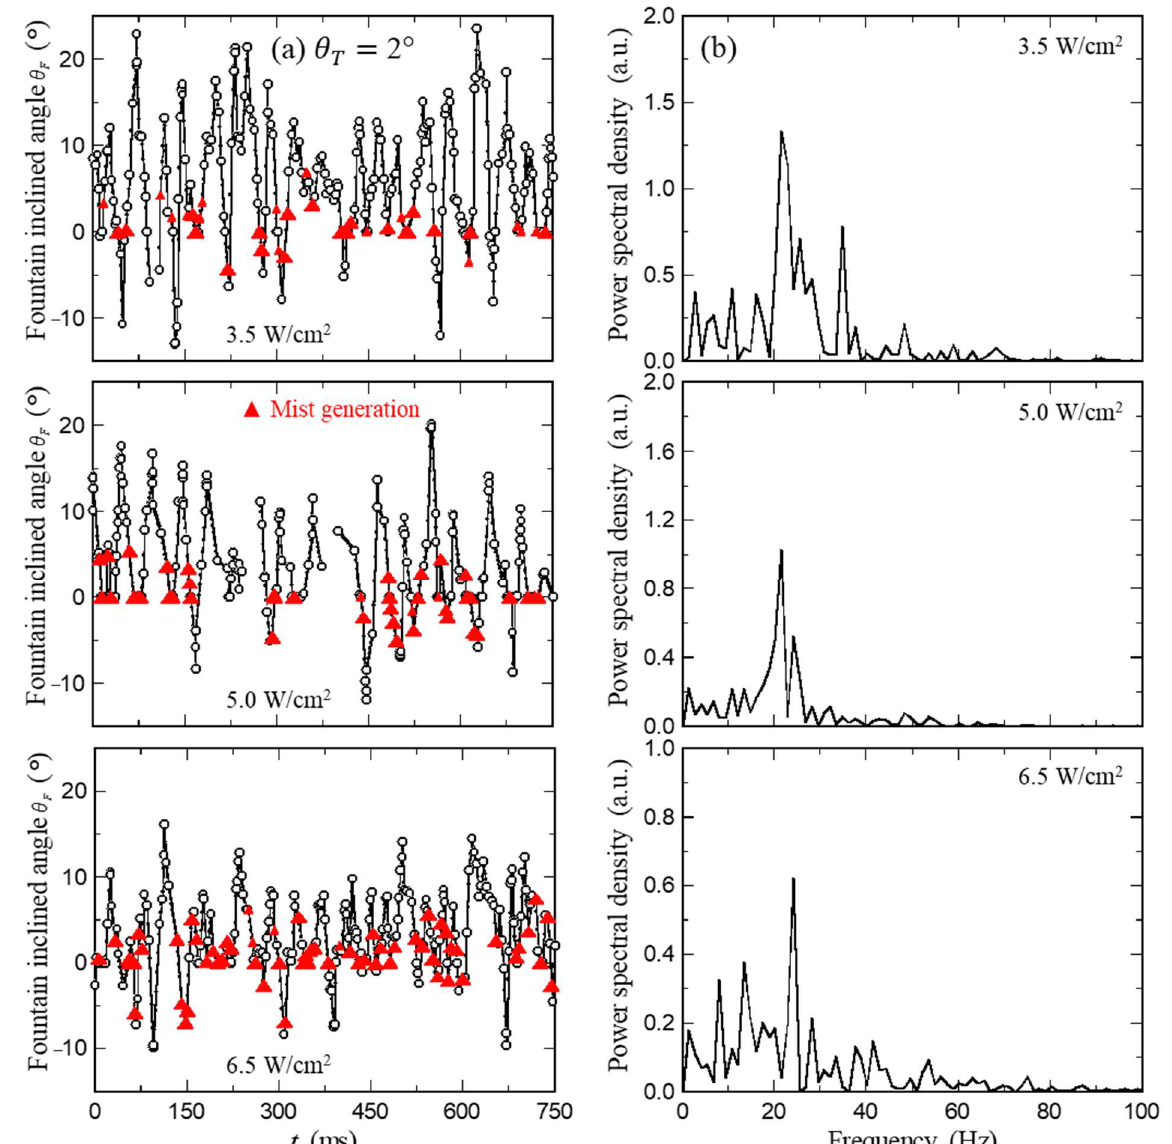
Figure 6. ( a ) Time variations in fountain inclined angle, associated with mist generation, for trans- ducer setting angle of 2 ◦ at input power densities of 3.5, 5.0, and 6.5 W/cm 2 , and ( b ) corresponding outcomes of FFT analysis for fluctuating inclined angle.